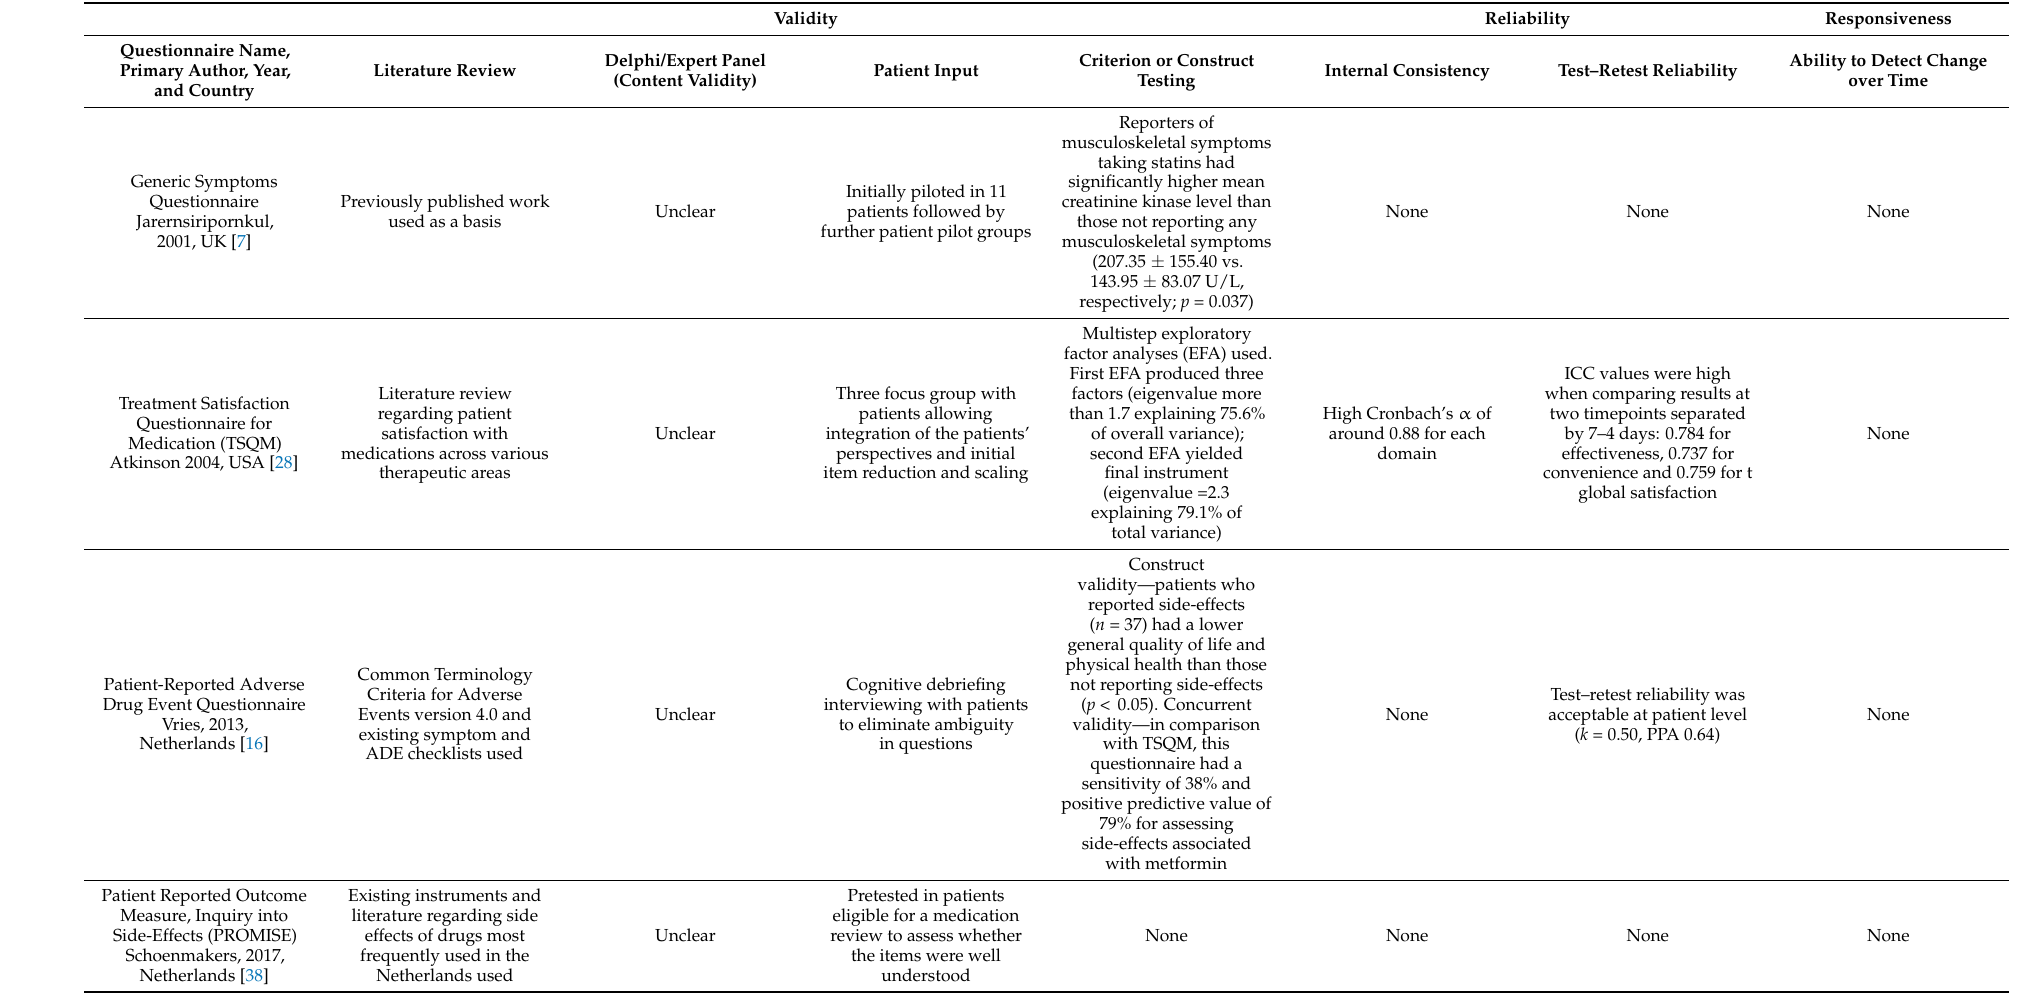
Table 3. Validity, reliability, and responsiveness of patient-reported side-effect questionnaires to identify adverse drug